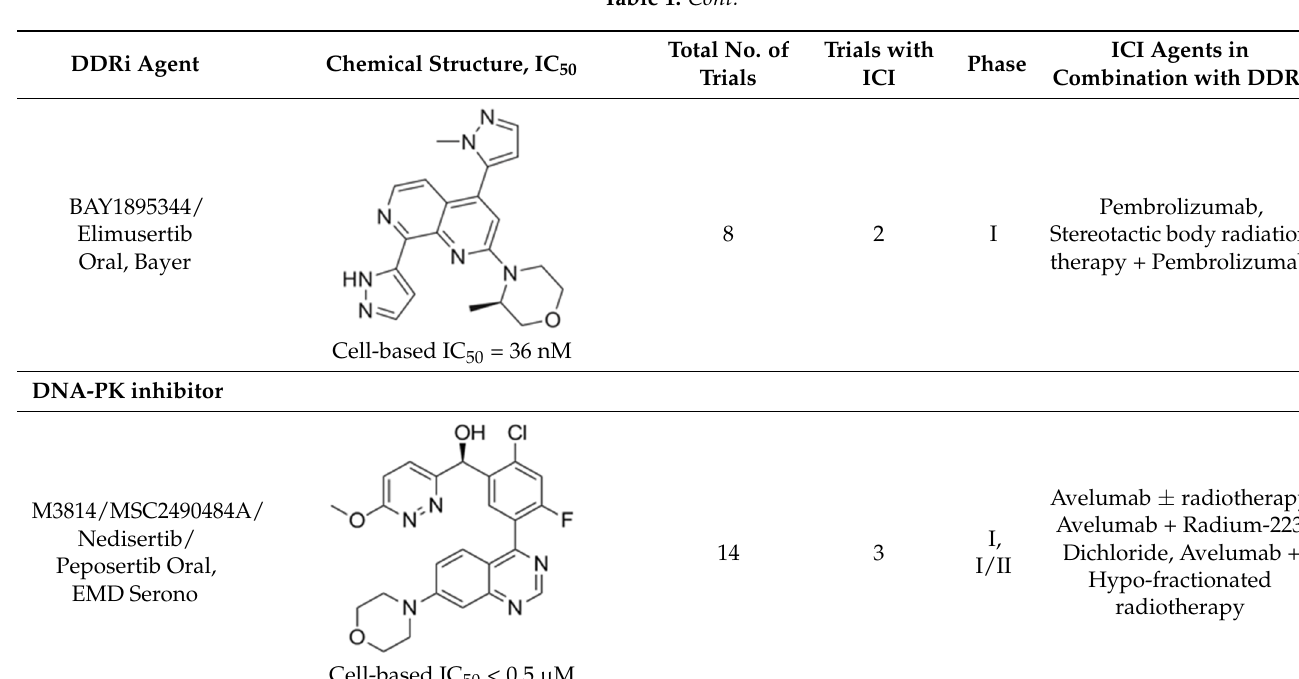
Table 1. Clinical trials pairing DNA damage response inhibitors (DDRi) with immune checkpoint inhibitors (ICIs). The inhibitory concentration (IC 50 ) indicates the potency of the inhibitor. ATM is not listed because no ICI combinations with ATM were listed on clinicaltrials.gov at the time of review. DDRi Agent Chemical Structure, IC 50 Total No. of Trials Trials with ICI